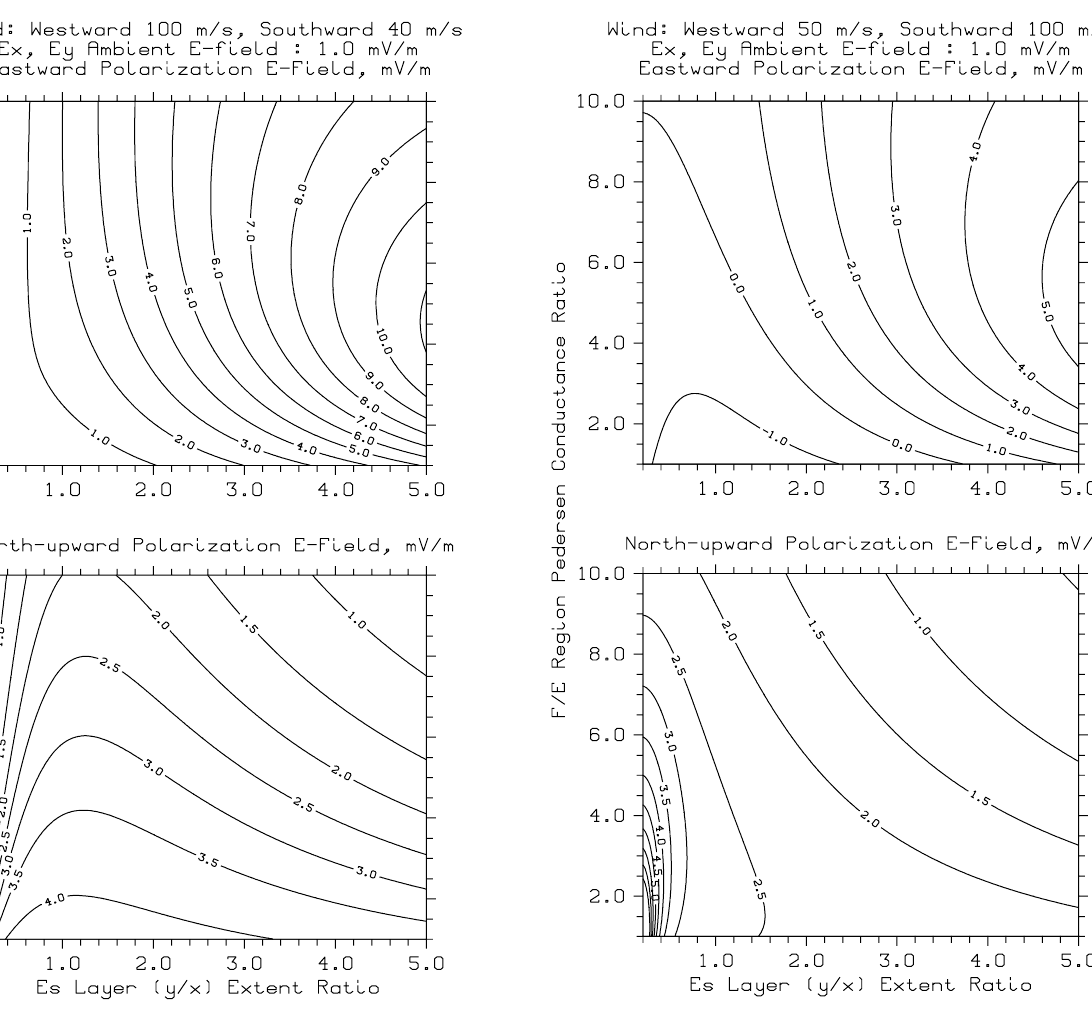
Fig. 2. Model predictions for the eastward (upper panel) and north- upward (lower panel) polarization fields inside a sporadic- E patch, as a function of the meridional to zonal patch extent ratio and the F to E region conductance ratio. The model predictions are for typical E region winds during unstable sporadic- E conditions, that is, with the wind having a westward component of 100m/s and a southward component of 40m/s. See text for more details.